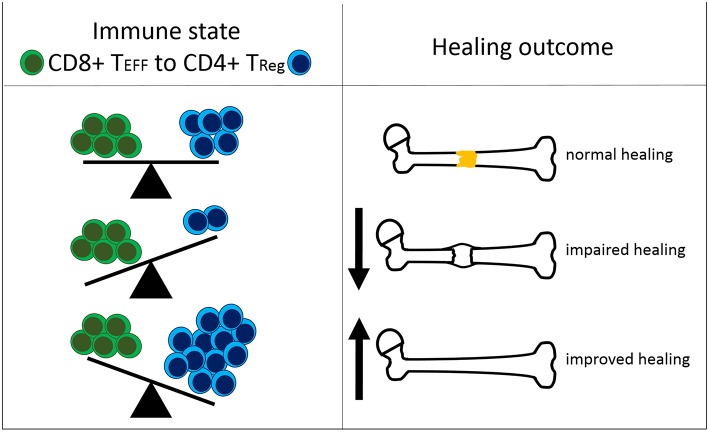
Interdependency of the immune status and the healing outcome after bone fracture. The ratio of CD8+ effector T cells (CD8+ TEFF) to CD4+ regulatory T cells (CD4+ TReg) affects the healing outcome after bone fracture. Under normal healing conditions, the T cell ratio is balanced. An elevated amount of CD8+ TEFF relative to CD4+ TReg is unfavorable for successful healing. A shifted balance in the CD4+ TRegsb direction improves bone fracture healing.